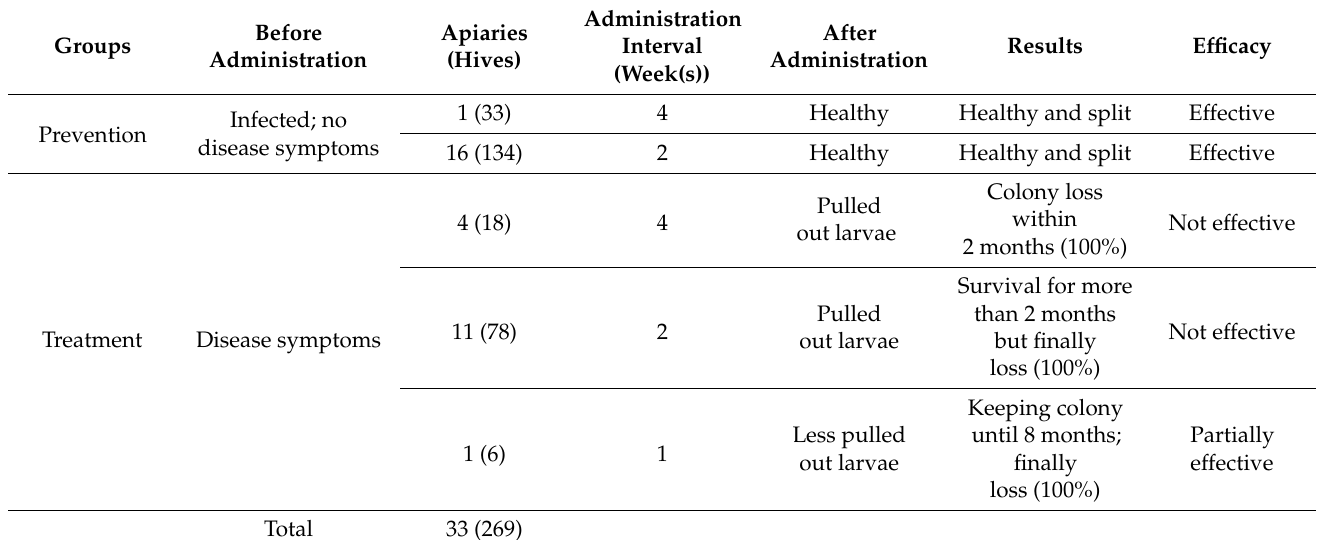
Table 2. Extended field application of double-stranded RNA (dsRNA) for the prevention and treatment of sacbrood virus